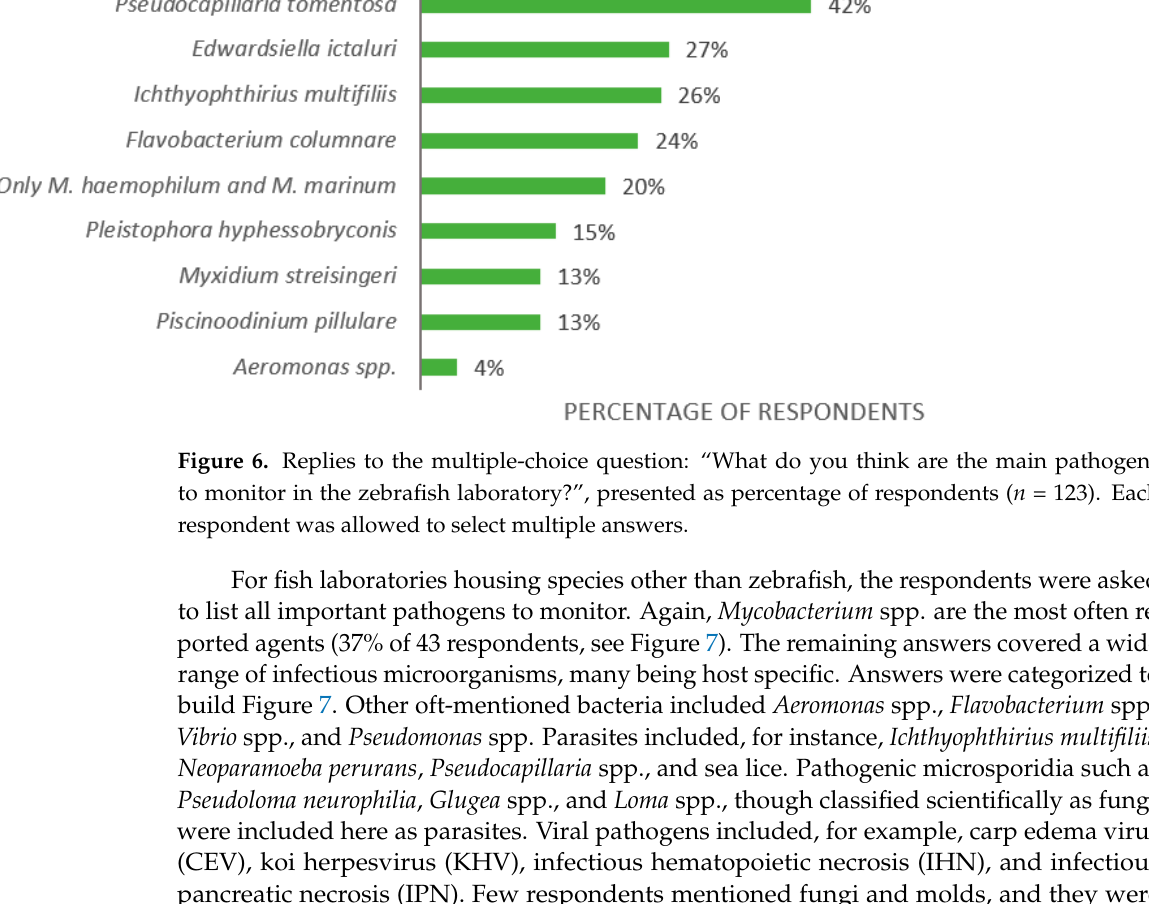
Figure 7. Replies to the open-ended question: “Please list what you consider the main pathogens to monitor in the fish (other than zebrafish) laboratory”, presented as percentage of respondents ( n = 43). Similarly, participants were asked about non-infectious diseases to monitor in laboratory fish (Figure 8). Of 49 valid responses, 47% of the respondents reported environmentally linked diseases (i.e., due to nutrition or water pollution from gas or